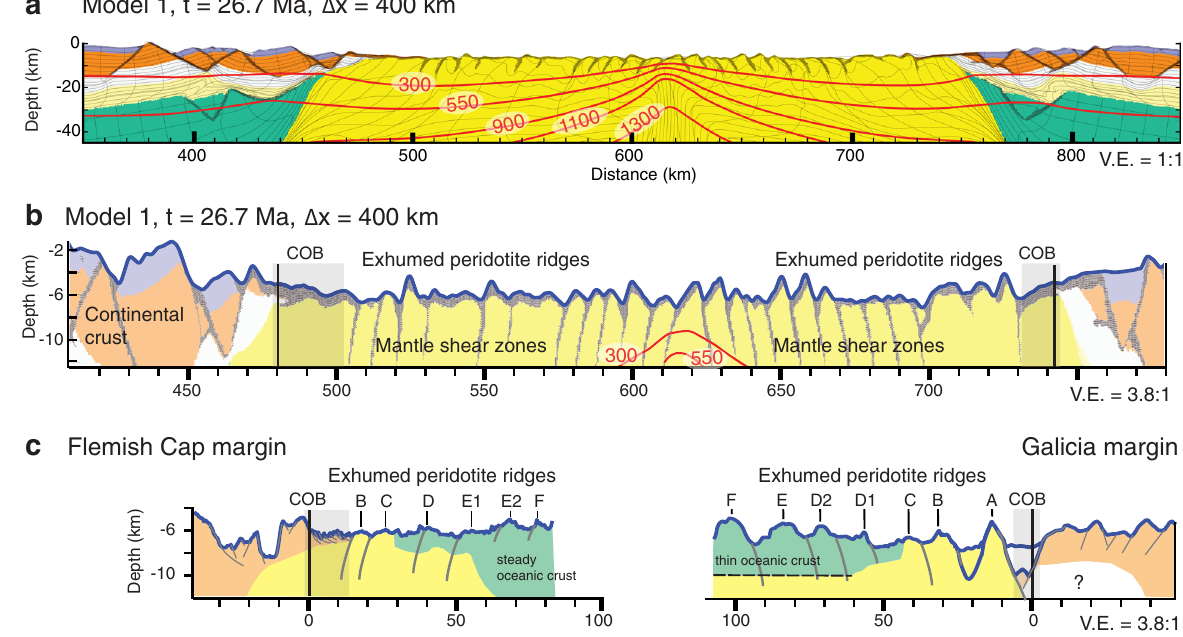
Fig. 2 Thermo-mechanical model of mantle exhumation during magma-poor rifted margin formation and Flemish Cap-Galicia conjugate margin geometry. a Numerical model results (shown for a sub-region of the model domain, see Supplement Movies S1 and S2 and Fig. S7 for full-time evolution). t = time since onset of extension, Δ x = extension at uniform velocity 1.5 cm/yr. Contours of isotherms in degrees Celsius. Shown are upper crust (orange), middle crust (white), lower crust (light yellow), pre-rift sediments (purple), lithospheric mantle (green), sub-lithospheric mantle (yellow), overlay of weakened frictional-plastic shear zones (gray). b Topography of the basement from the numerical model with vertical exaggeration. We note that the density structure of this model is not calibrated to fi t the relative elevation between continents and mid-ocean ridge resulting in over-estimated depth. Colors: same as in a . c Topography of the top basement offshore along SCREECH-1 and WE-1/ISE-1 seismic pro fi les with the same vertical exaggeration. Gray: interpreted shear zones responsible for the successive formation of basement highs named here with a